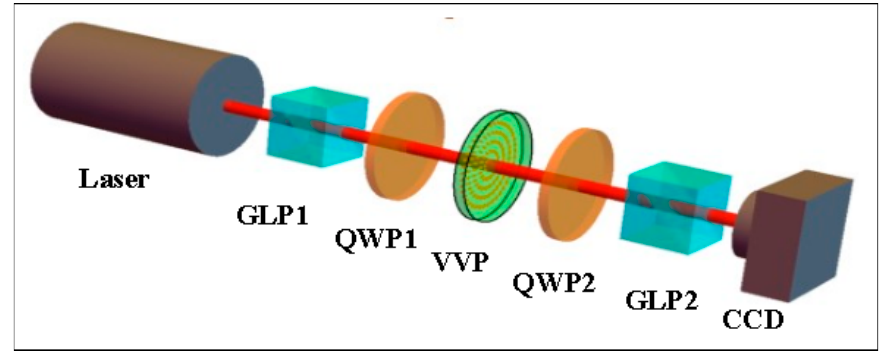
Figure 4. Experimental setup to generate arbitrary vector vortex beams on the hybrid-order Poincaré sphere. GLP, Glan laser polarizer; QWP, quarter-wave plate; VVP, vector-vortex plate; CCD, charge- coupled device.